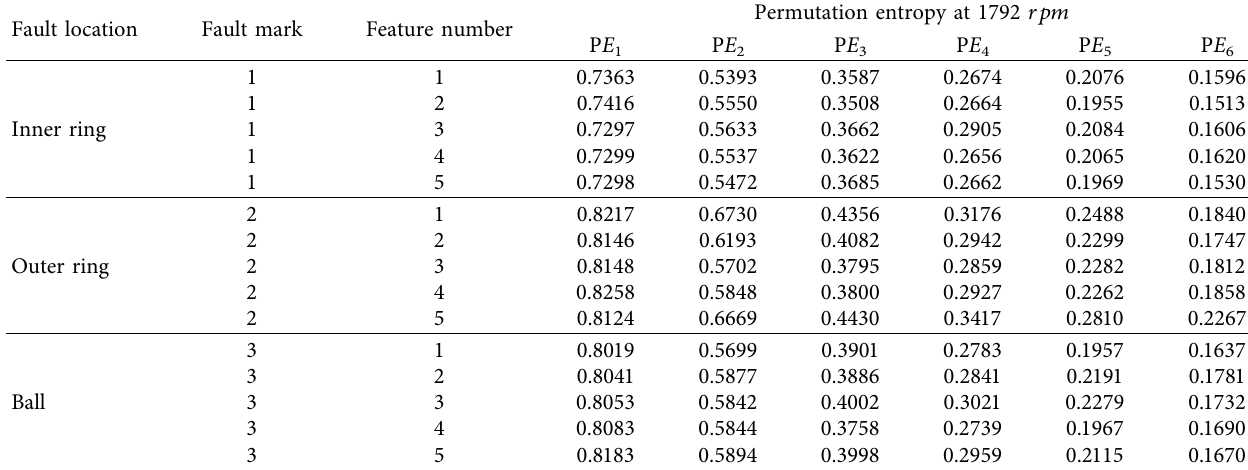
Table 8: Permutation entropy at 1792 rpm.